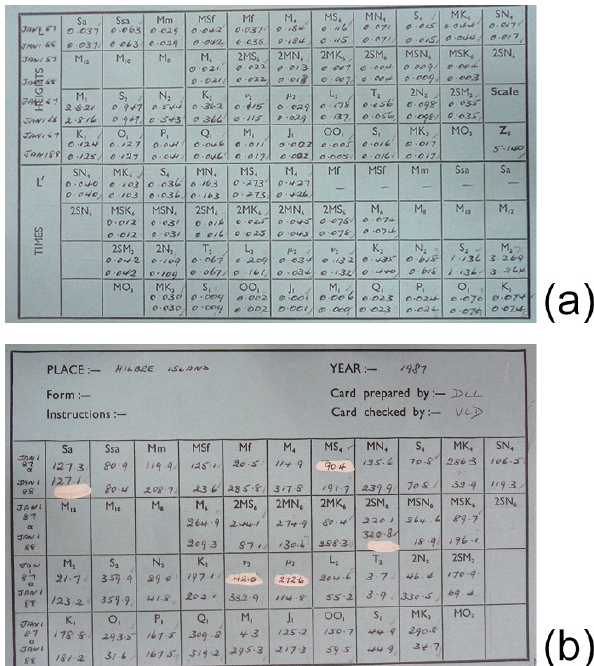
Figure 7. (a, b) The two sides of a relatively recent “running card” for use with the Bidston Doodson–Légé Machine, in this case for producing predictions for Hilbre Island in 1987 and 1988. (Card courtesy of Valerie